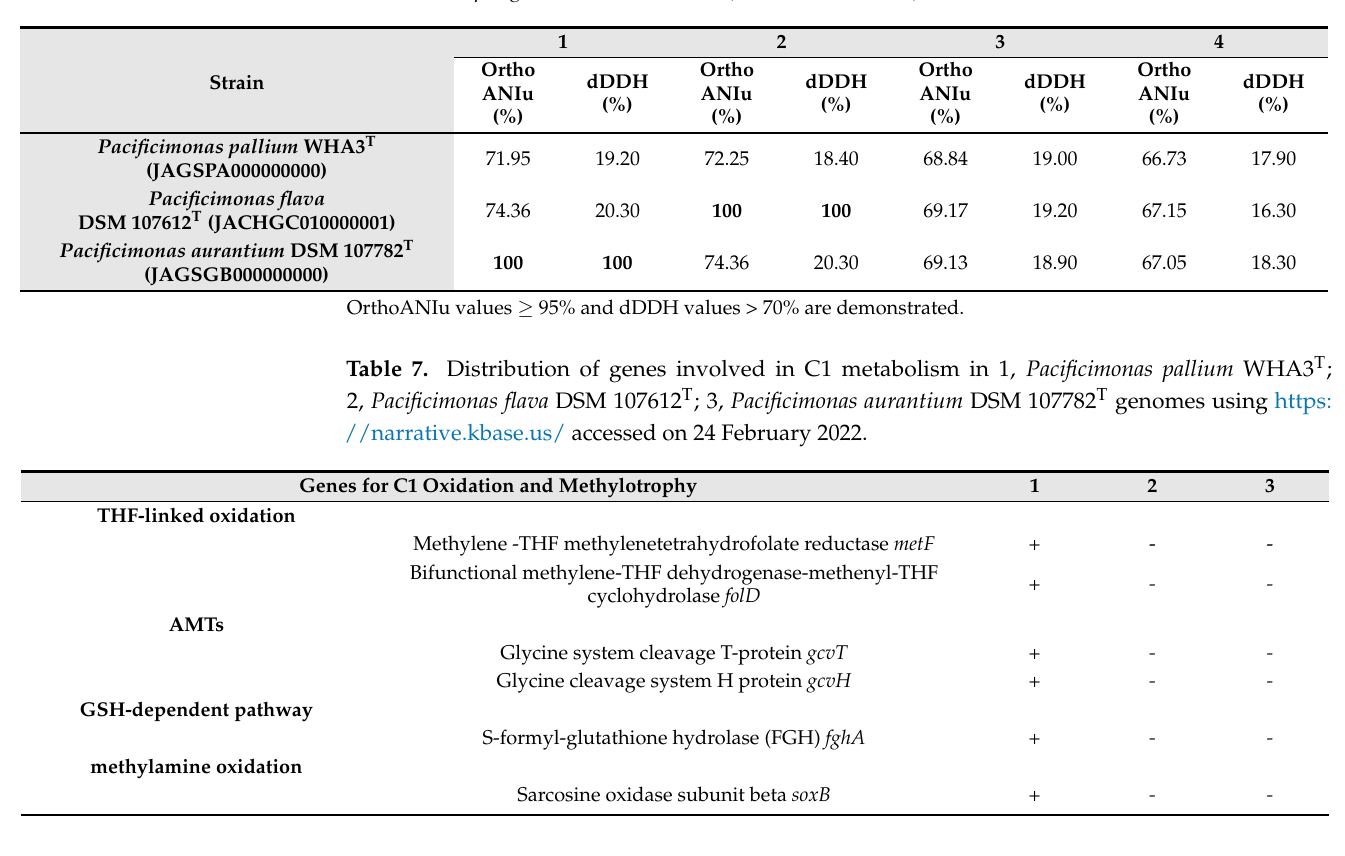
Table 6. ANI and dDDH values of the strain Pacificimonas sp. WHA3 T and its closely related type strains. 1, Pacificimonas aurantium DSM 107782 T (JAGSGB000000000); 2, Pacificimonas flava DSM